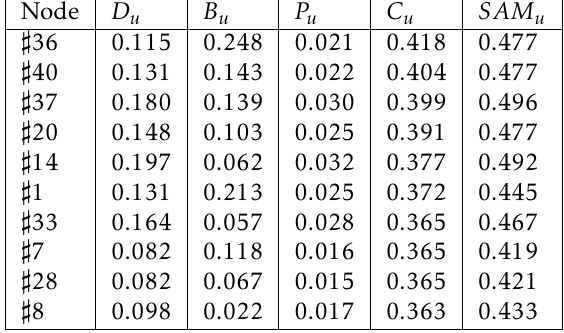
Table 3. Centrality Score of Top 10 Nodes, From Dolphin Dataset, Sorted by SAM Centrality